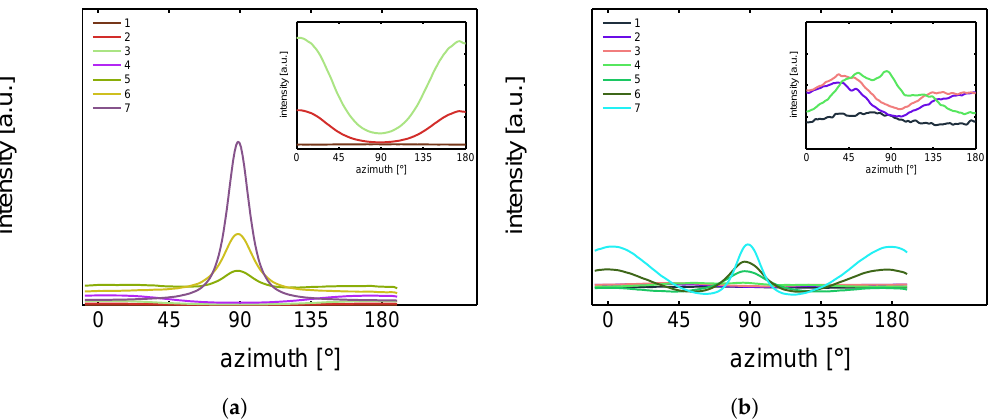
Figure 26. Azimuthal intensity of the lamellar scattering at various strains of γ -iPP. ( a ) uni-axial stretching at 25 ◦ C and ( b ) 110 ◦ C. The numbers in the legend correspond to the 2D patterns in Figure 25. To quantify the void fraction, the 2D patterns are integrated according to Equation (22), which holds for the assumption of cylindrical symmetry, and by substitution of the result into Equation (23), the evolution of void fraction as a function of the strain is obtained. This procedure was applied on the α -, β - and γ -iPP for all the experimental conditions, and the result is shown in Figure 27. The increase of the void fraction becomes particularly clear at the strain where macroscopic yielding takes place. Based on the 2D images this can be linked to the transition of perpendicularly oriented voids towards voids parallel to the tensile direction, which coincides with a large increase in the scattering intensity. In the case of α -iPP deformed at 25 ◦ C, φ v increases simultaneously with